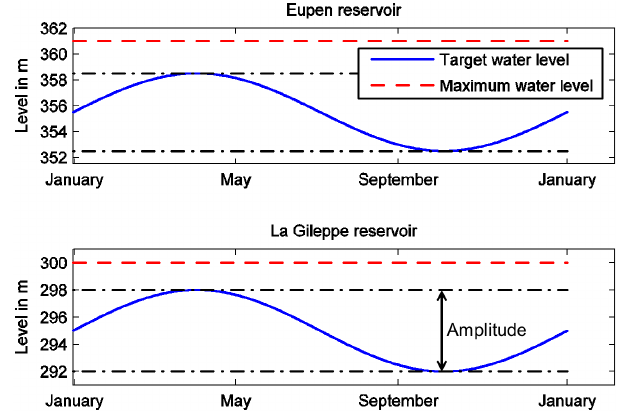
Table 1. Summary of the reservoir characteristics.